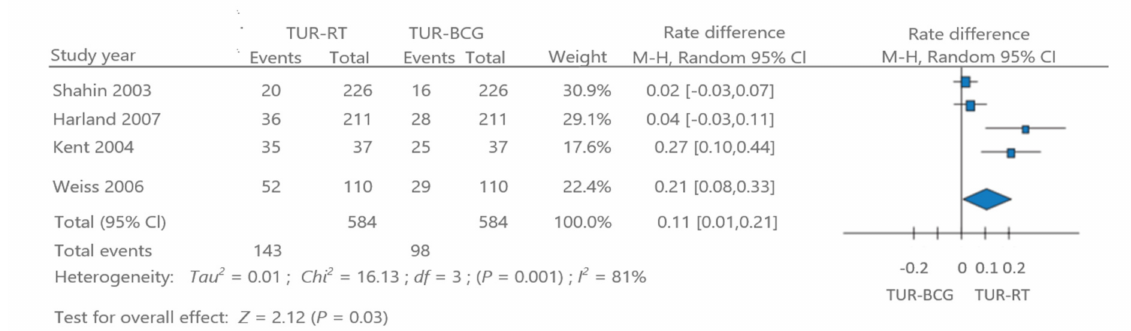
Figure 12 (df: degree of freedom; M-H: Mantel-Haenszel), meta-analysis showed that the overall cystitis AEs and complications relative to TURBT-Radiation therapy versus TURBT- BCG Immunotherapy ranged from 2% to 27%. This showed a significantly higher cystitis SE rate by TURBT-Radiation therapy than TURBT-BCG Immunotherapy (rate difference 11%; 95% CI; 2–27%; p = 0.03; I 2 = 81; χ 2 = 16.13).